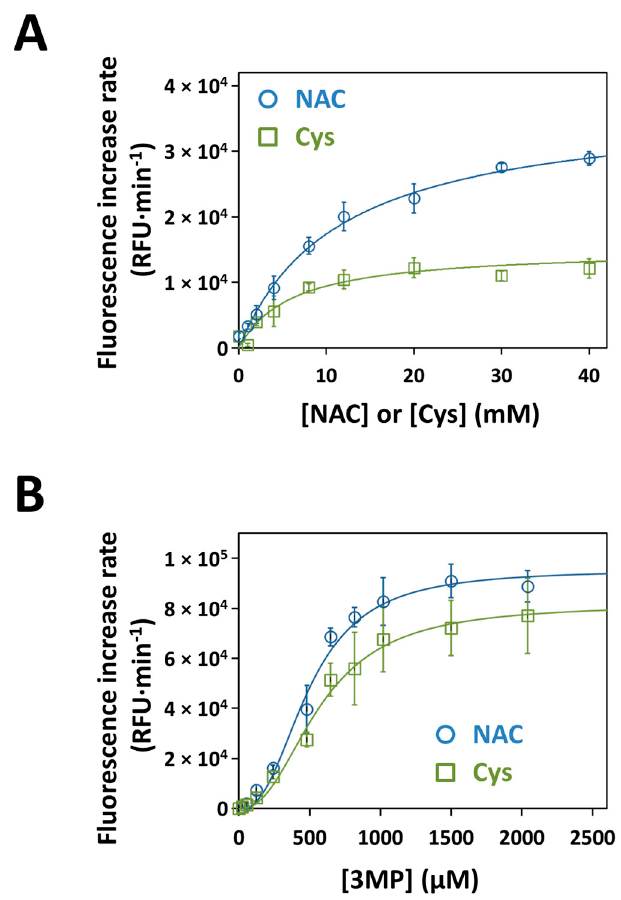
Figure 4. Kinetics of H 2 S generation by MST. (Panel A ) H 2 S-synthesizing activity of MST measured at varying concentrations of Cys or NAC. The reaction mixture contained 10 µ g recombinant human MST, 0–40 mM NAC (blue) or Cys (green), 50 µ M 7AzC and 0.5 mM 3MP in a total assay volume of 250 µ L, as described in Materials and Methods. Bu ff er: 200 mM Tris-HCl pH 8.0 Data represent the mean values ± SD of at least two independent experiments, each in technical triplicate. (Panel B ) H 2 S-synthesizing activity of MST measured at varying concentrations of 3MP. The reaction mixture contained 0–2 mM 3MP, 20 mM of NAC (blue) or Cys (green). Other experimental conditions as reported in panel A. Data represent the mean values ± SD of at least two independent experiments, each in technical triplicate.